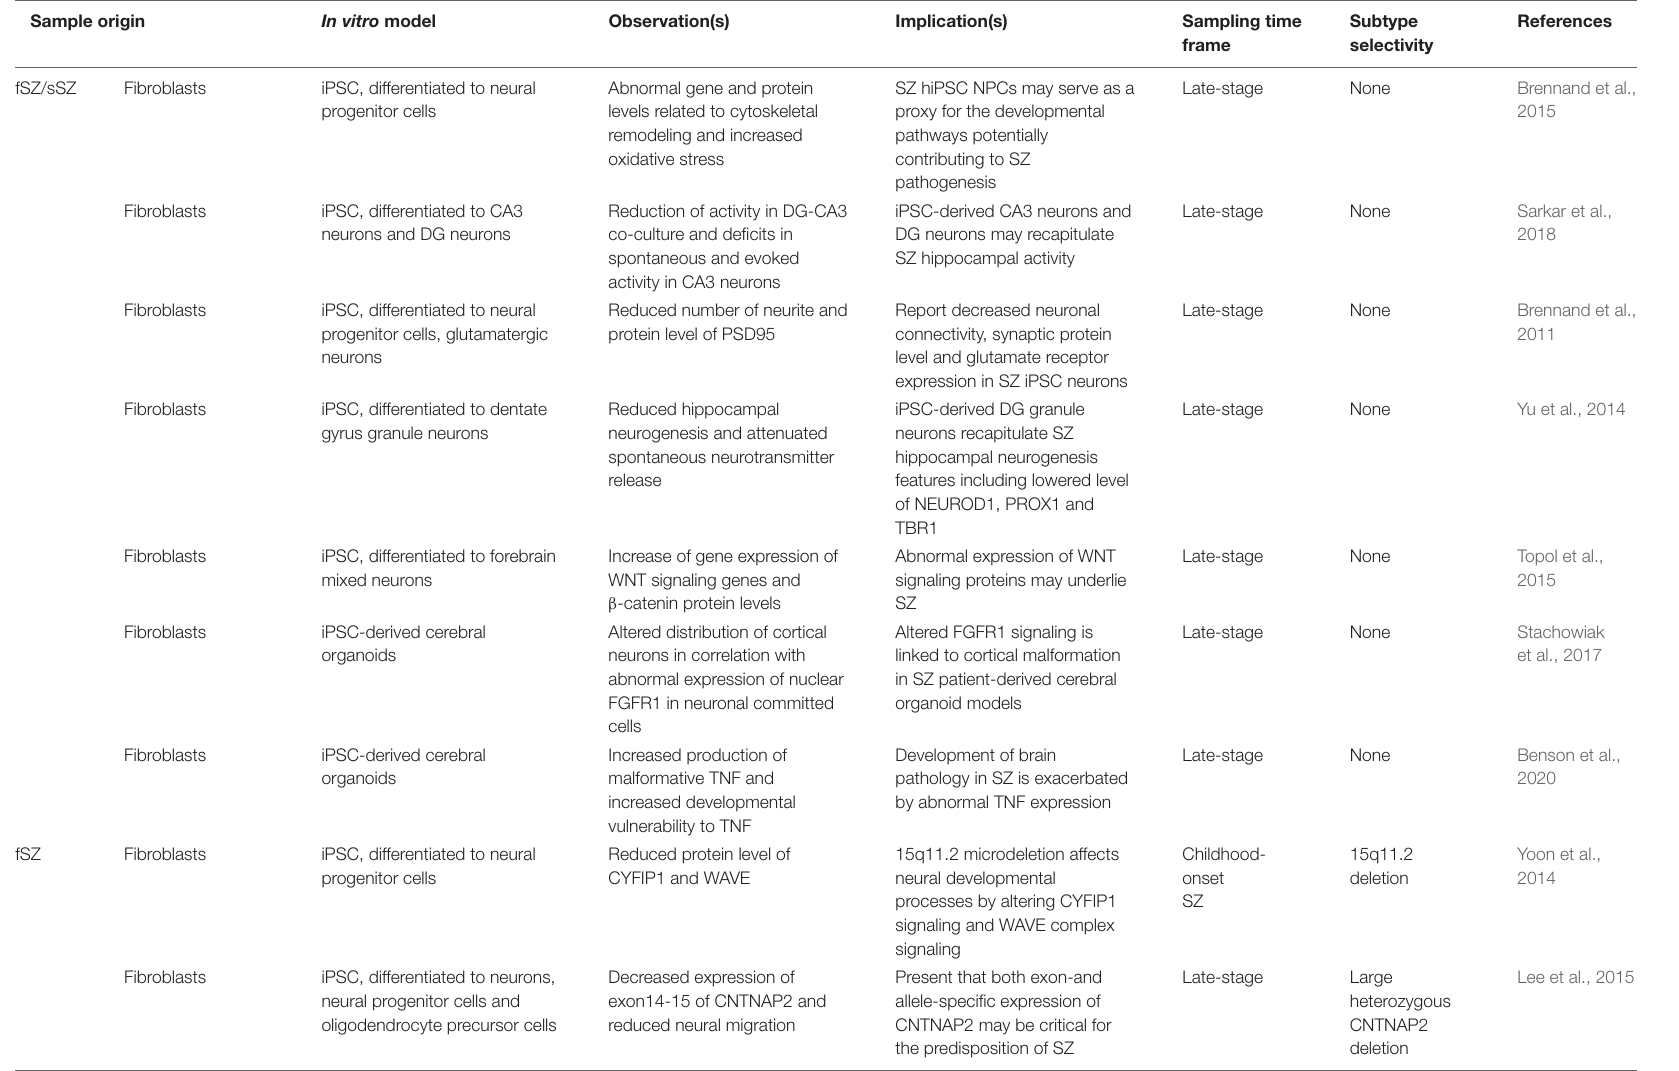
TABLE 2 | Selected reports utilizing iPSC models and organoid technologies for the characterization of